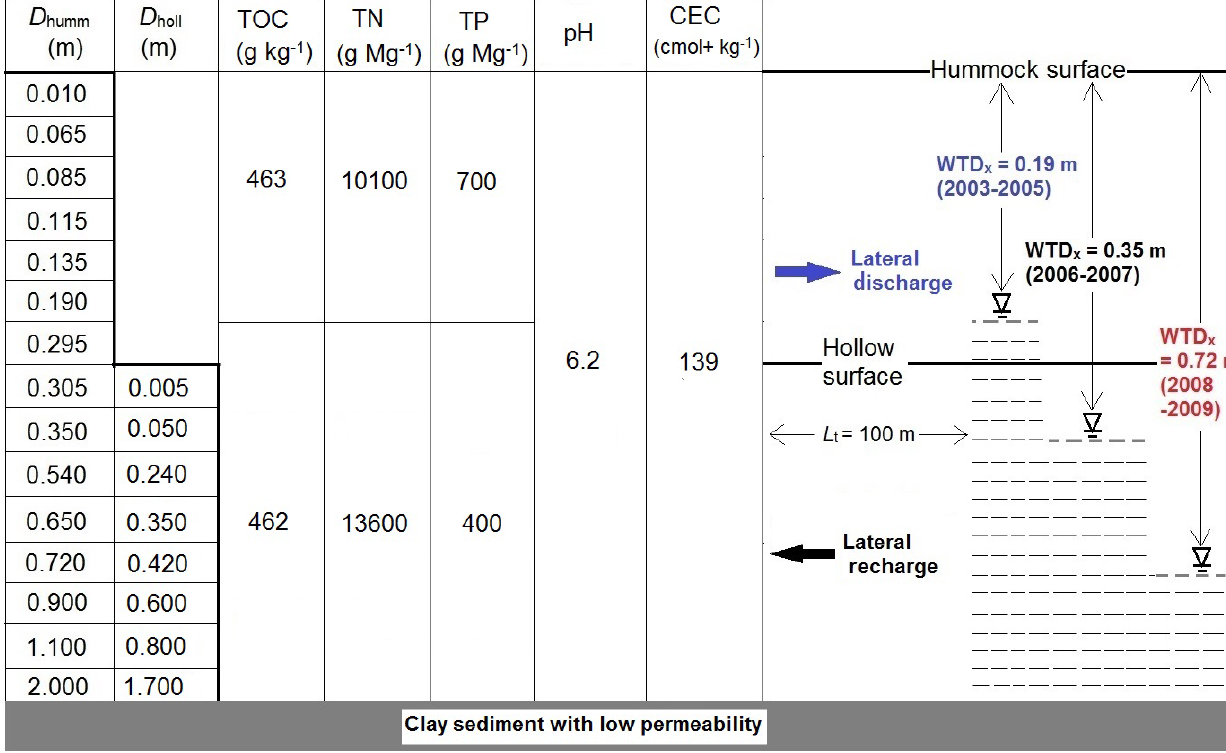
Figure 2. Layout for ecosys model run to represent biological, chemical and hydrological characteristics of a western Canadian fen peatland. Figure is not drawn to scale. D humm : depth to the bottom of a layer from the hummock surface; D holl : depth to the bottom of a layer from the hollow surface; TOC: total organic C (Flanagan and Syed, 2011); TN: total nitrogen (Flanagan and Syed, 2011); TP: total phosphorus (Flanagan and Syed, 2011); CEC: cation exchange capacity (Rippy and Nelson, 2007) – the value for pH was obtained from Syed et al. (2006); WTD x : external reference water table depth representing average water table depth of the adjacent ecosystem; L t : distance from modeled grid cells to the adjacent watershed over which lateral discharge/recharge